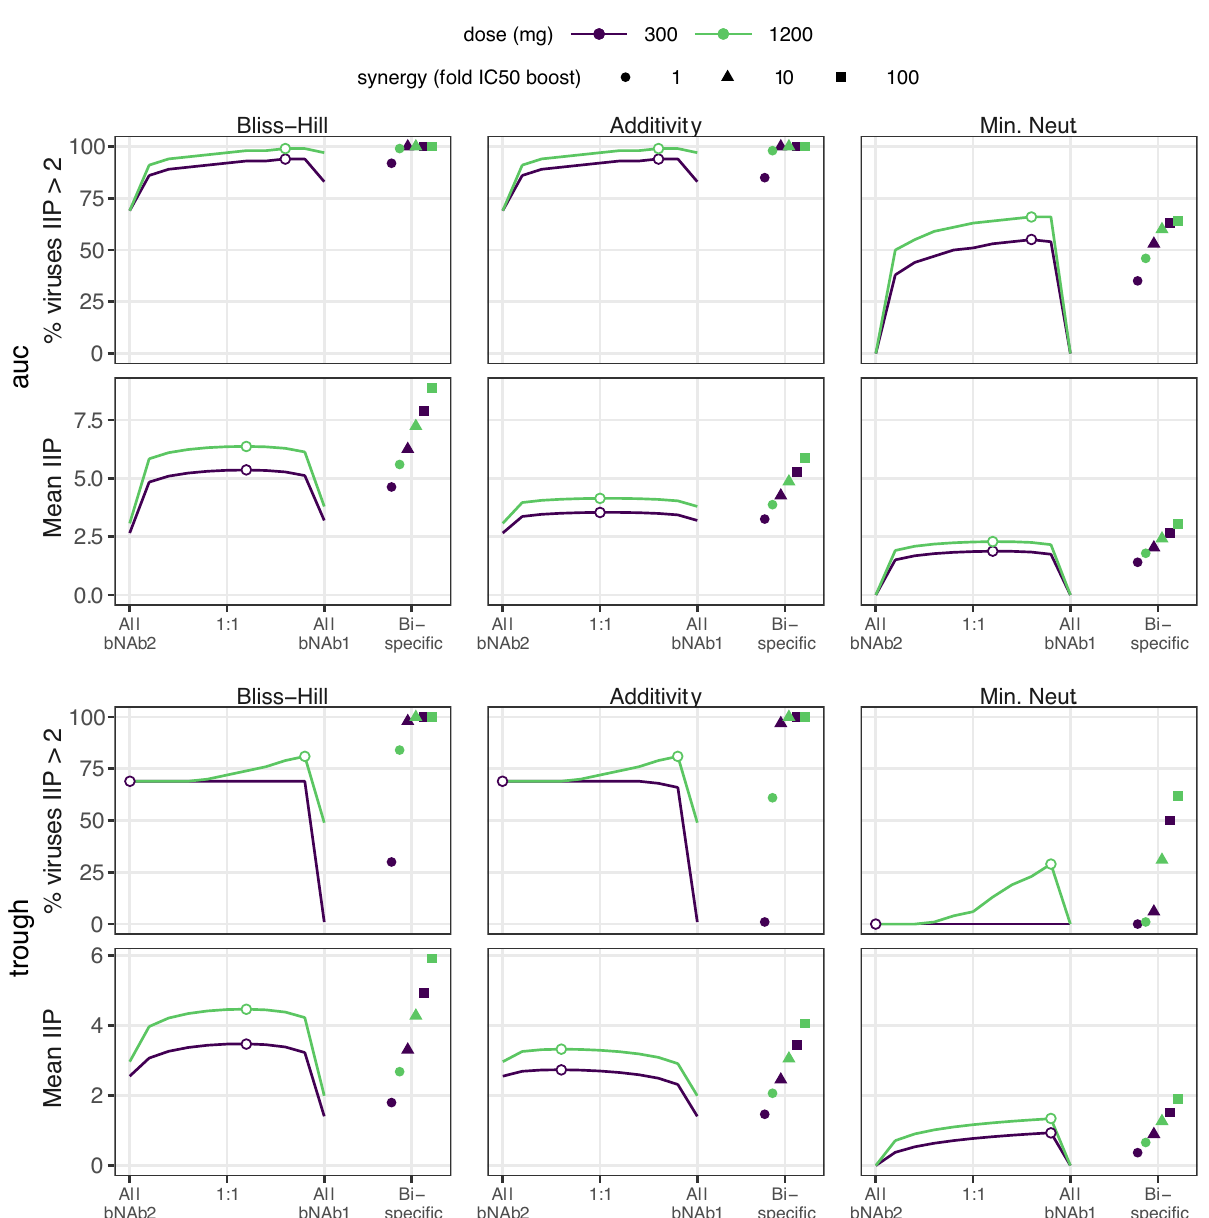
Fig 4. Optimizing 2 bNAb combination therapy in comparison to bi-specific therapy with the same bNAbs. Combination antibody results for AUC (top) and trough (bottom) suggest that trough is slightly more sensitive to ratio (see curvature of outcome surface and change from optimal ratio denoted by open dot). In general, a single bi-specific bNAb will perform worse than combination therapy if it has the best neutralization potential of both parental lineages under a common interaction model but inherits the faster clearance kinetics. However, if synergetic binding occurs, enhancing the bi-specific potency by 10-fold (see Methods ), it is similar or outperforms the optimal combination for all outcomes and doses. “All bNAb1” and “All bNAb2” on the x-axis correspond to 100% dosing of the second bNAb product.